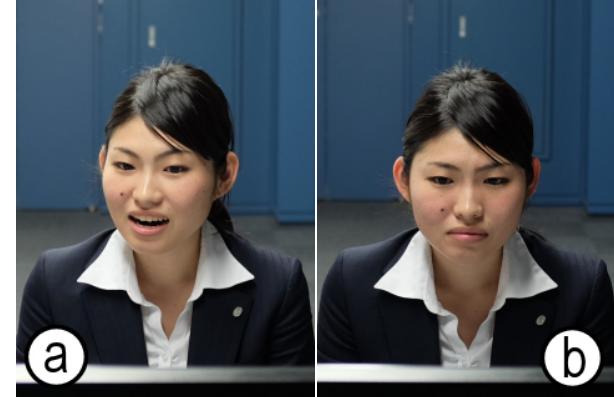
Figure 8. Example of neutral (a) and negative (b) non-verbal cues for a Japanese subject. We consider astonishment (a) as neither positive nor